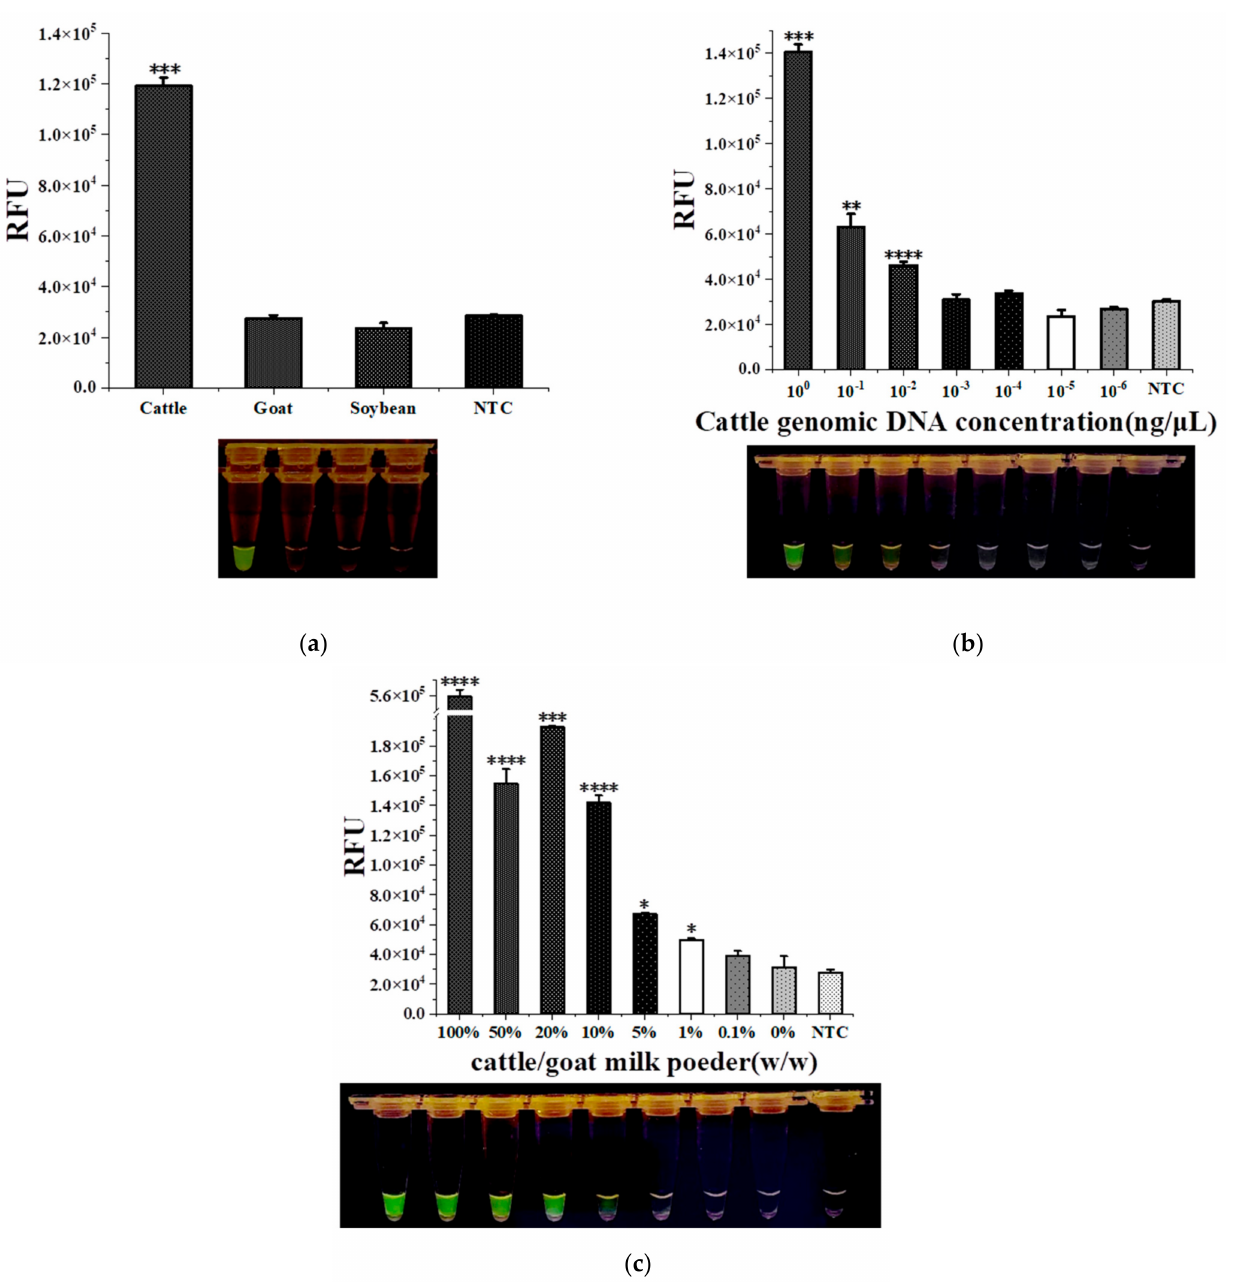
Figure 4. Specificity and detectability of RPA-CRISPR/Cas12a. ( a ) The specificity of RPA- CRISPR/Cas12a. ( b ) The absolute detectability of RPA-CRISPR/Cas12a. ( c ) The detection limit of adulteration ratio. NTC: nontarget control (ddH 2 O) (* p < 0.05, ** p < 0.01, *** p < 0.001, **** p <